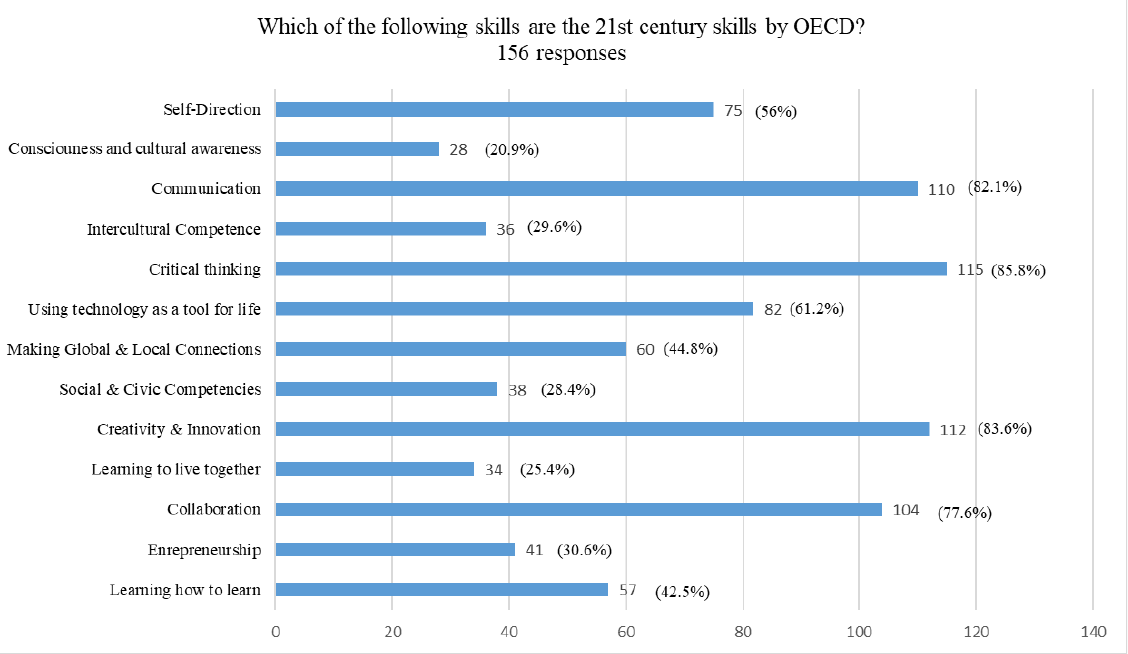
CHART 2. ALIGNMENT OR MISALIGNMENT WITH OECD